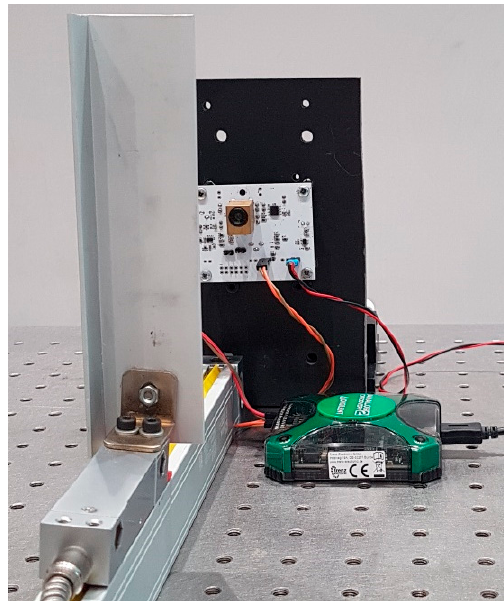
Figure 9. Experimental setup.